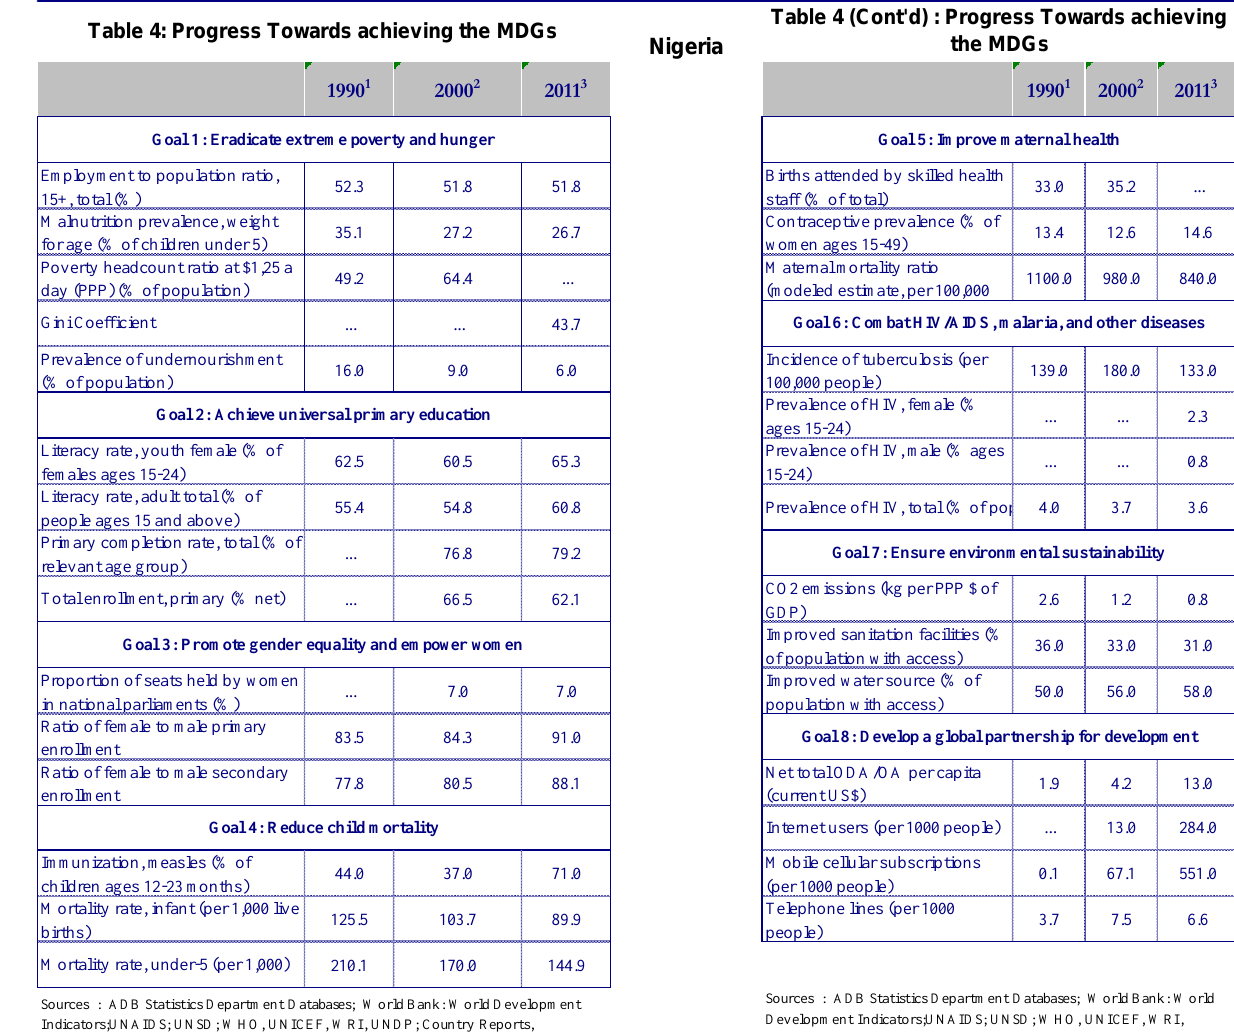
Table 4: Progress Towards achieving the MDGs